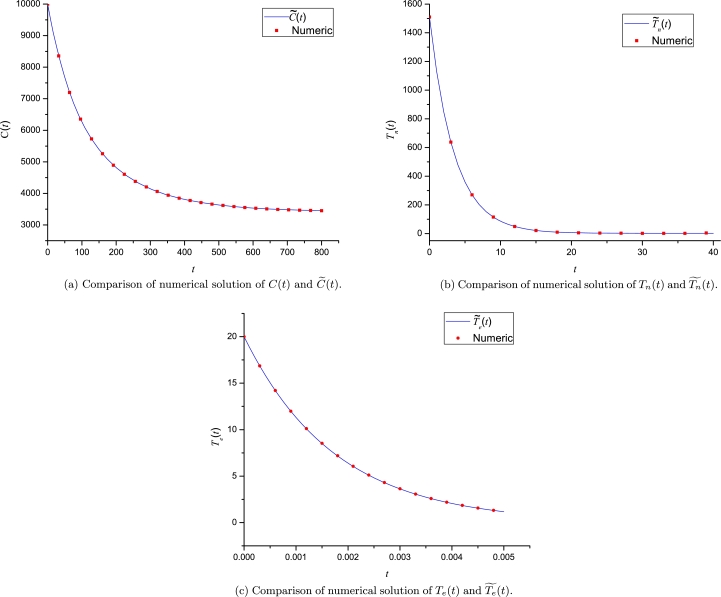
Numerical solutions and LP approximations for (27).